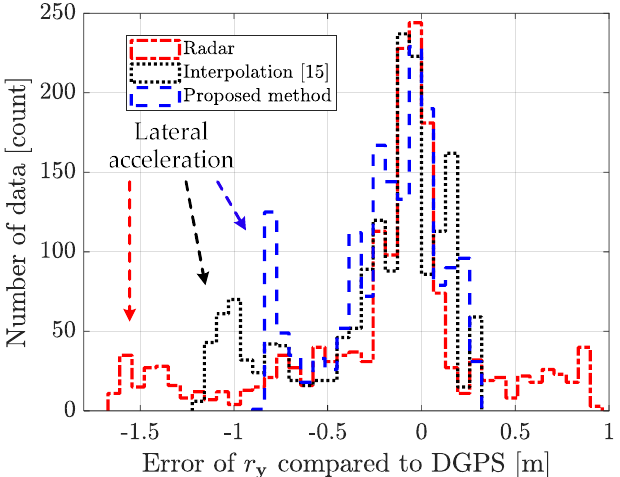
Figure 14. Histogram of the lateral distance error for scenario-based object estimation: using the weighted interpolation method improves the estimation performance statistically. However, there is a lateral position error due to latency for lateral acceleration via the lane change motion of the object